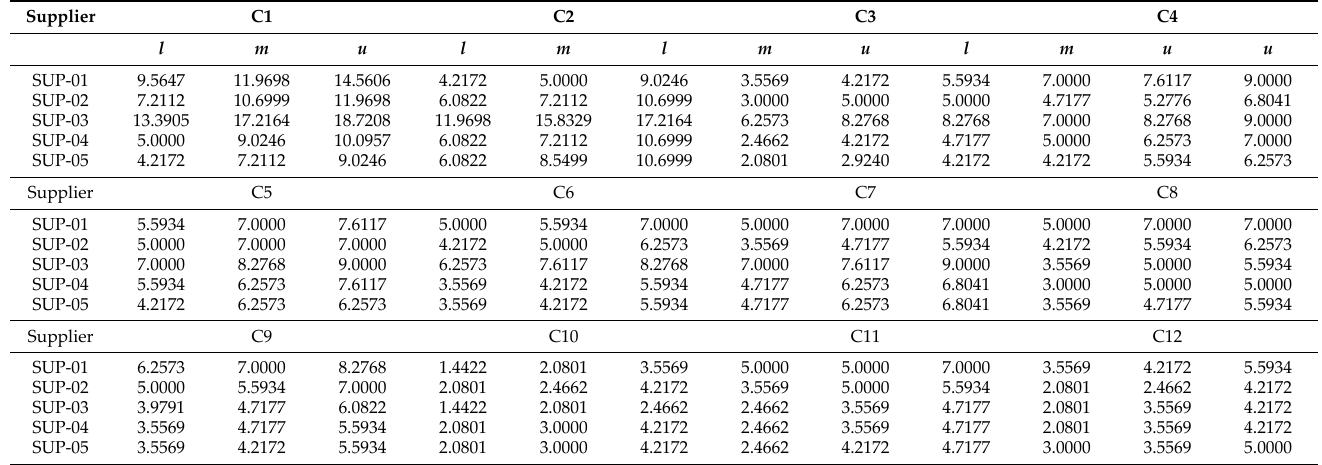
Table 7. The integrated matrix for fuzzy